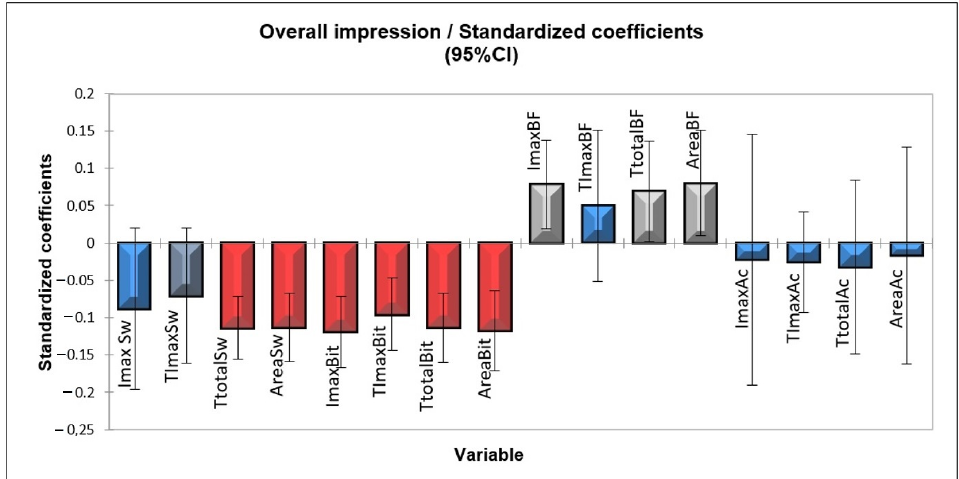
Figure 5. Preference drivers of blackberry nectar. Legend: ImaxSw = Maximum intensity of sweet taste; TImaxSw = Maximum intensity time to sweet taste; TtotalSw = Total time of sweet taste; AreaSw = Area under the curve of sweet taste stimulus; ImaxBit = Maximum intensity of bitter taste; TImaxBit = Maximum time to intensity of bitter taste; TtotalBit = Total time to bitter taste; AreaBit = Area under the curve of bitter taste stimulus; ImaxBF = Maximum intensity of blackberry flavor; TImaxBF = Maximum time to intensity of blackberry flavor; TtotalBF = Total time blackberry flavor; AreaBF = Area under curve of blackberry flavor stimulus; ImaxAc = Maximum intensity of acidic taste; TImaxAc = maximum intensity time to of acidic taste; TtotalAc = Total time acidic taste; AreaAc = Area under the curve of acidic taste stimulus. The PLSR analysis graphically shows the positive or negative importance of the parameter’s time-intensity curves, evidencing the consumers’ preference drivers. The columns on the positive part of the y-axis (gray) represent parameters with positive importance, whereas the columns on the negative part of the y-axis (red) represent parameters whose presence is negative to acceptance of the blackberry nectar. The vertical lines represented in the boxes (columns) of the parameters of time-intensity curves (coefficients) are the confidence intervals. If the confidence interval exceeds (crosses) the x-axis to the opposite side, it means that the corresponding parameter is not significant ( p > 0.05) in the consumer’s preference (blue columns). However, if the confidence interval does not cross the x-axis to the opposite side, this coefficient (parameter of the curve) is significant for consumer preference ( p < 0.05), and it contributes positively or negatively to consumer preference if the bar is facing the positive or negative side of the y-axis, respectively.4. CATA